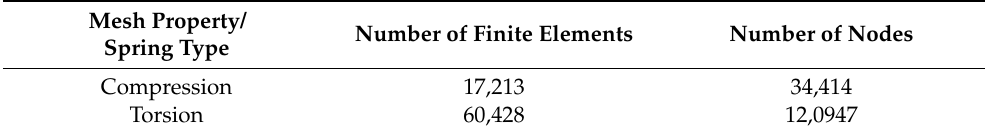
Table 2. Number of finite elements and nodes for specific spring